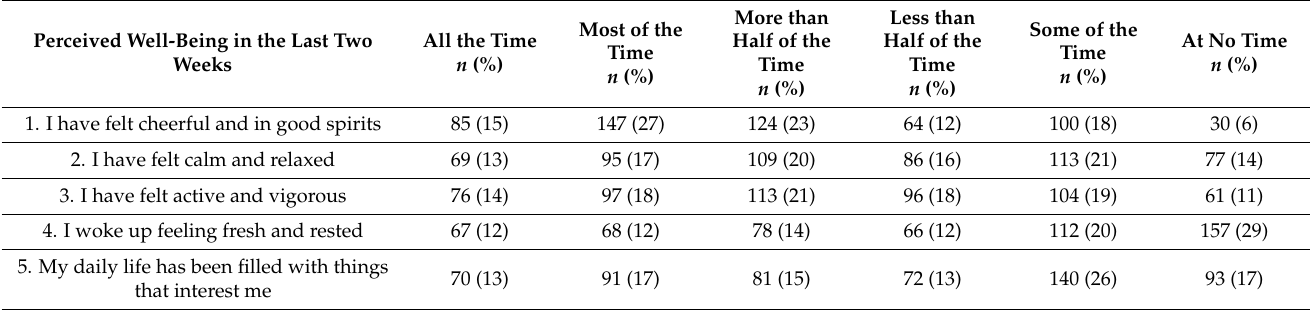
Table 2. The responses of participants to the WHO-5 Well-Being Index ( n = 552).